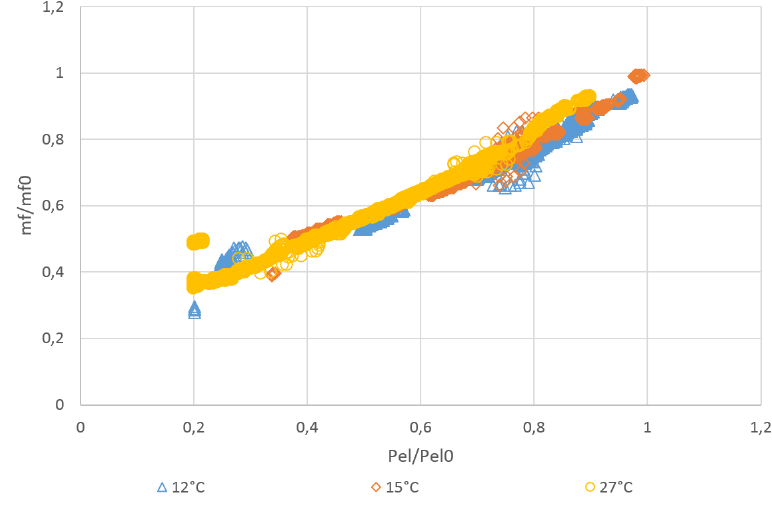
Figure 3. Fuel consumption for operating points at three different ambient